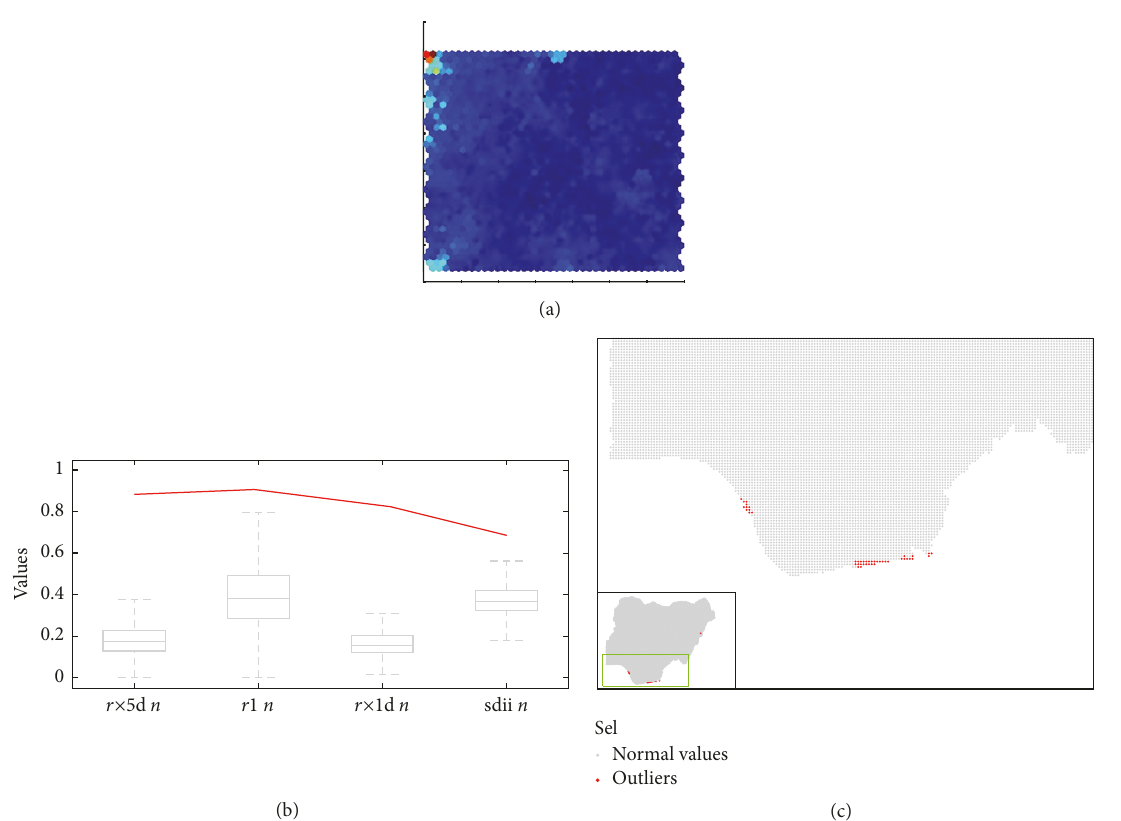
Figure 4: U-matrix (a), boxplot (b), and map (c) of the four precipitation indices showing outliers in red in 2003.